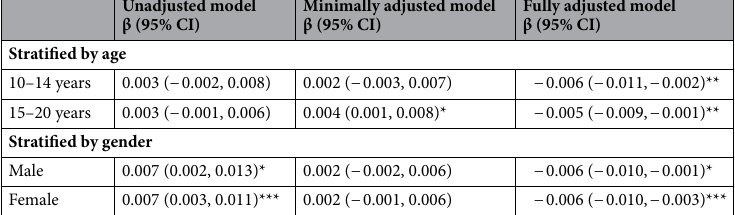
Table 4. Association between HS-CRP (mg/L) and total BMD (g/cm 2 ), stratified by age and sex. Unadjusted model adjust for: None. Minimally adjusted model adjust for: age, gender, race. Fully adjusted model adjust for: age, gender, race, BMI, income-poverty ratio, education level, alkaline phosphatase, cholesterol, calcium, phosphorus, globulin, and total protein. Gender is not adjusted in the subgroup analysis stratified by gender, and age is not adjusted in the subgroup analysis stratified by age. * P < 0.05, ** P < 0.01, *** P <